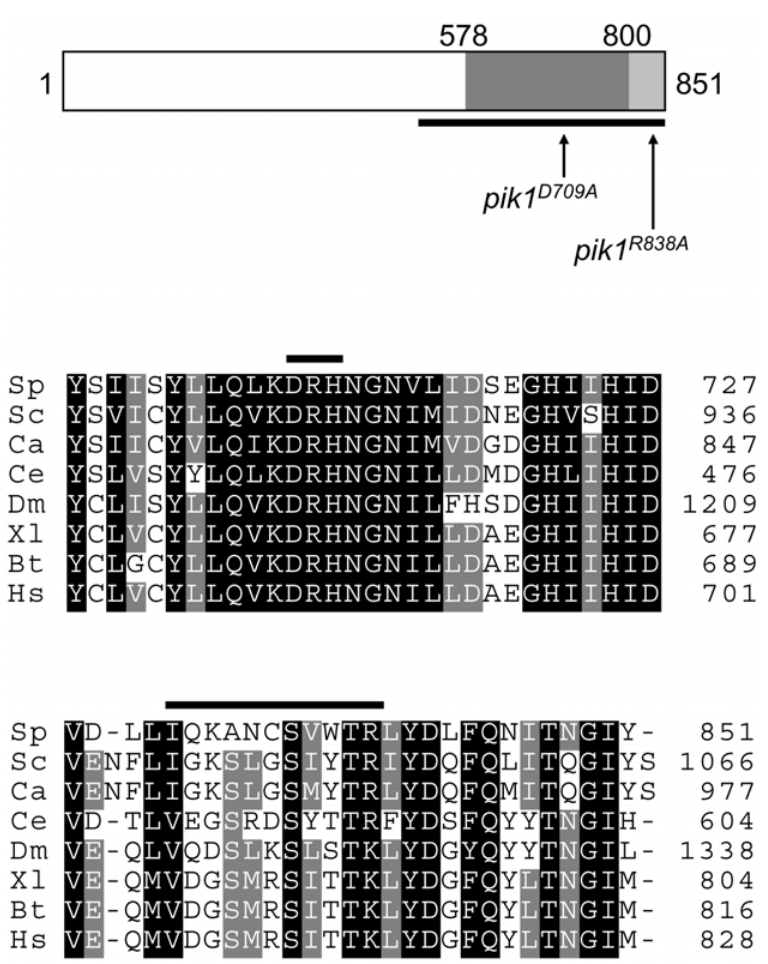
Figure 5. The C-terminal region of Pik1 is conserved. (A) Schematic representation of the primary structure of S. pombe Pik1 is shown. The kinase domain was identified from sequence similarity comparison to known lipid kinases using Prosite (grey shaded regions), or using Pfam (dark grey region only). A pseudo IQ motif is in the light grey shaded region. The positions of site-directed mutations in the kinase domain and in the pseudo IQ motif are indicated. (B) Sequence of the C-terminal region of S.pombe Pik1 (Sp; Accession CAA93903) is compared to those of orthologs in Saccharomyces cerevisiae (Sc; CAA53658), Candida albicans (Ca; CAA09718), Caenorhabditis elegans (Ce; NP_508177), Drosophila melanogaster (Dm; NP_728519), Xenopus laevis (Xl; Q6GN16), bovine (Bt; 002810) and human (Hs; BAA21661). The lipid kinase DRH motif and the C-terminal pseudo IQ motif (IQxxxRGxxxR) are indicated by black bands.